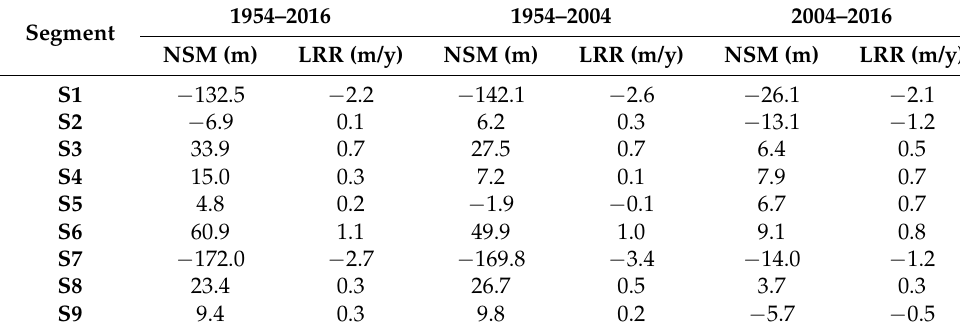
Table 4. Long and mid-term shoreline changes along the Molise